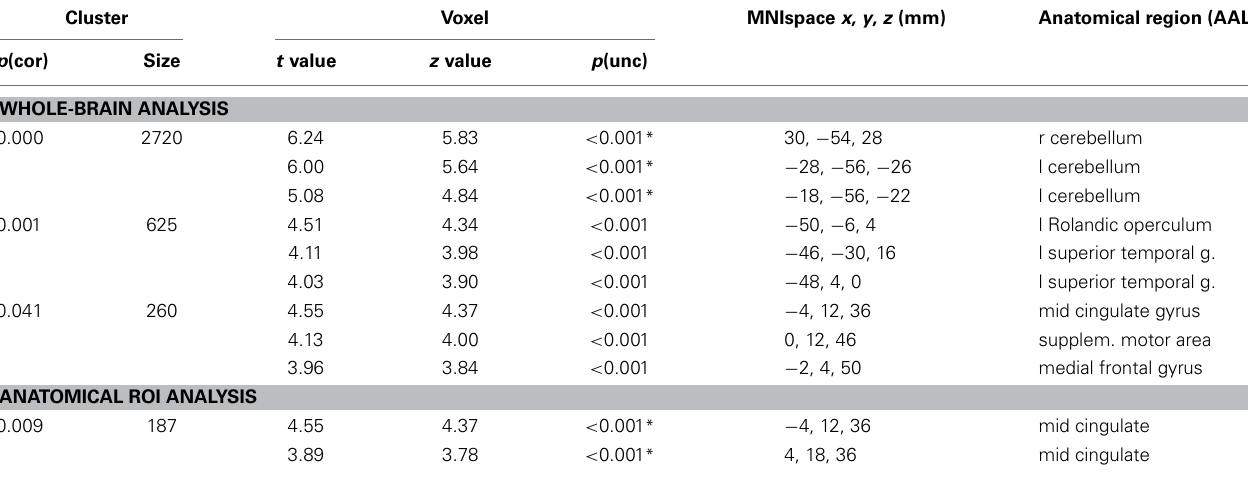
Table 5 | Statistically significant activations in the whole-brain and ROI analyses for the conjunction of the PWI, Stroop, and Simon tasks. Cluster Voxel MNIspace x , y , z (mm) Anatomical region (AAL)